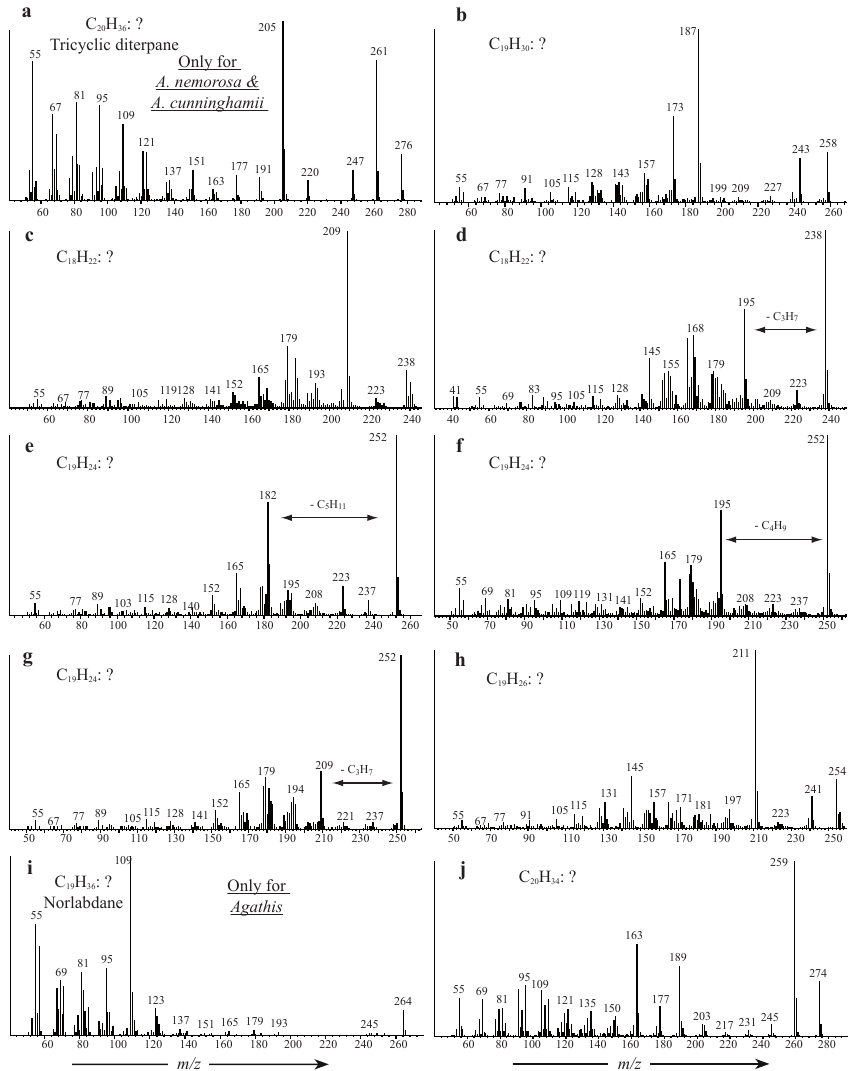
Fig. 9. Mass spectra of some unidentified, but recurrent Araucariaceae diterpenoids. (a) (only for A. nemorosa and A. cunninghamii in Fig. 6), (i–j) (only for Agathis , in Fig. 11): in the aliphatic fraction; (b–g) in the aromatic fraction (Figs. 6 and